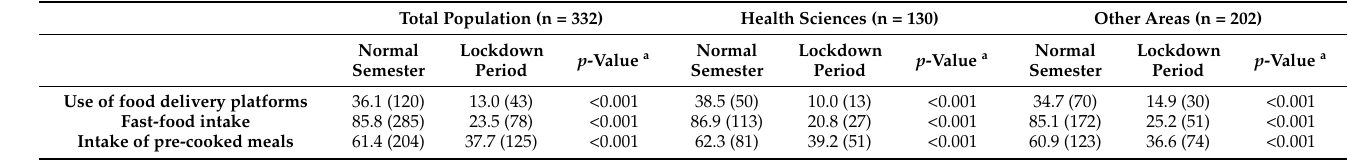
Table 3. Use of delivery platforms and self-reported consumption of external meals between the normal semester and the lockdown period due to the COVID-19 pandemic, according to the study area. Total Population (n = 332) Health Sciences (n = 130) Other Areas (n = 202) p -Value